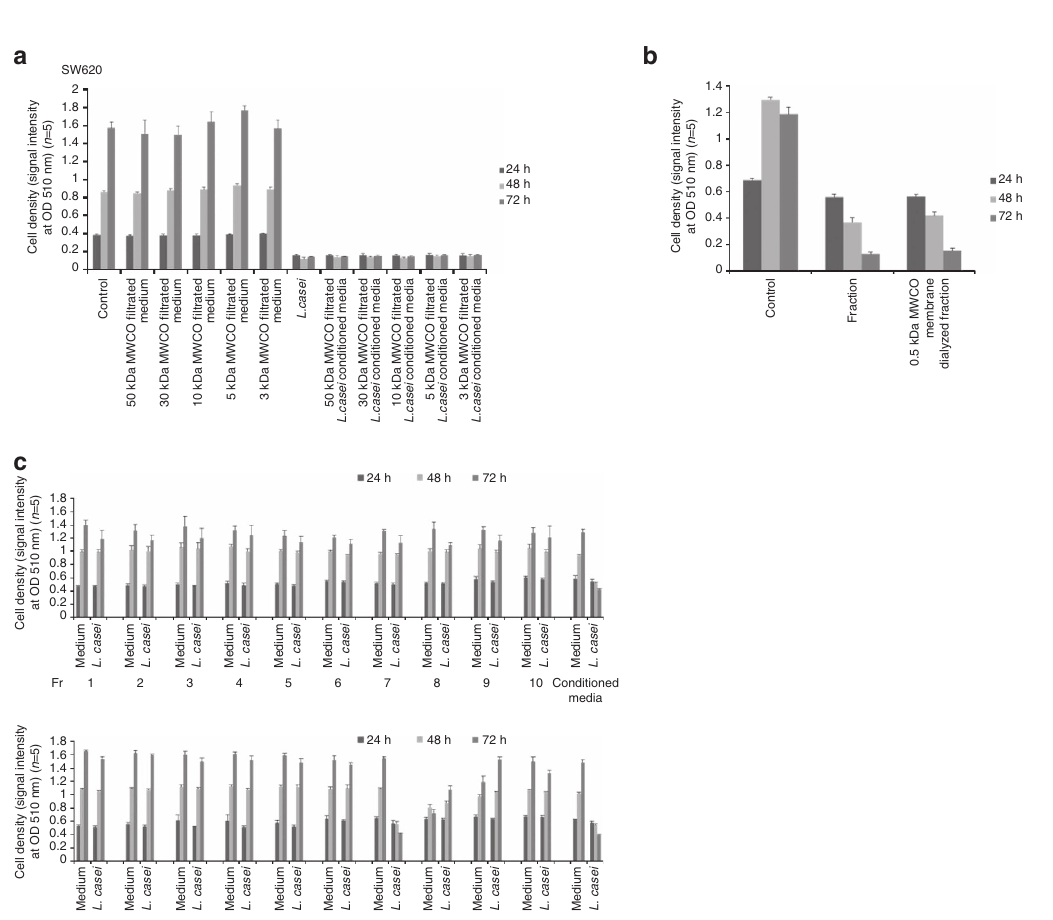
42 MAPK (ERK), protein kinase B (Akt), c-jun N-terminal kinase (JNK), p38MAPK and Glycogen synthase kinase 3 b (GSK3 b ) signalling pathways were assessed. A western blotting analysis